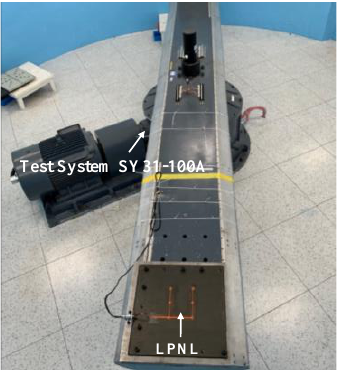
Figure 17. Experimental setup of overload tests. Table 3. Overload test conditions.